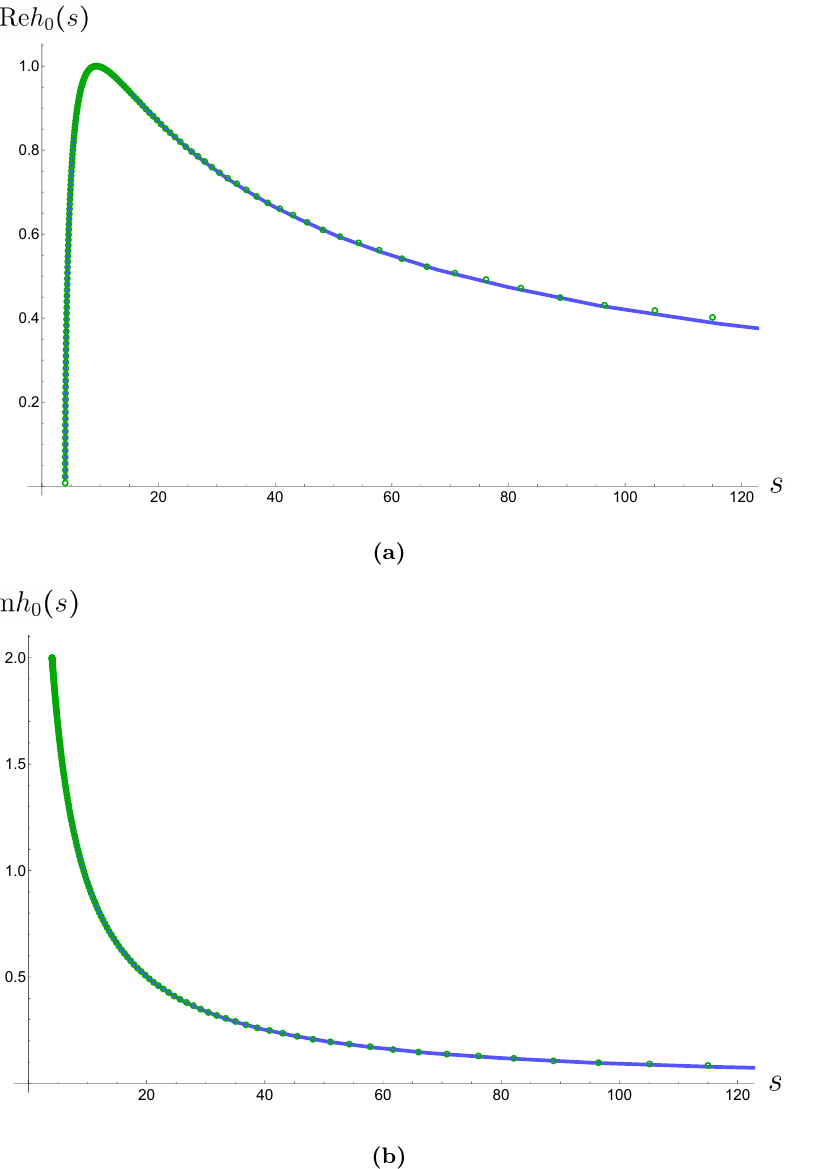
Figure 5. Real and imaginary parts of the S-wave h 0 ( s ) for the amplitude from maximizing at the symmetry point. The blue curve is the primal result by imposing a threshold pole, and the green circles are the dual result using the expression (3.44) without assuming the threshold pole. The two agree